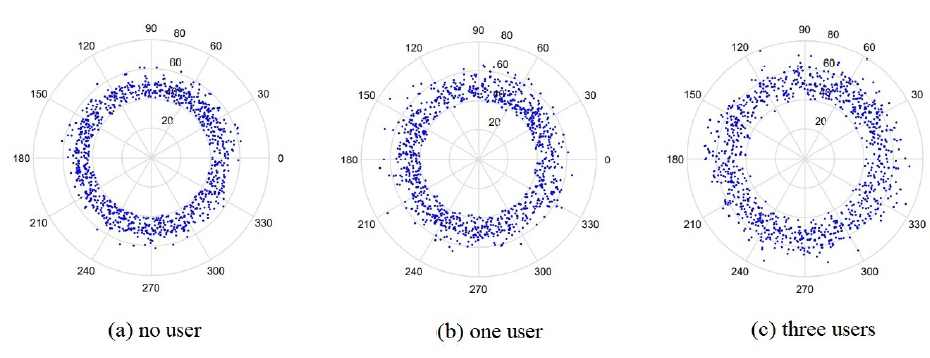
Figure 9. Impact of the number of users on RSSI.